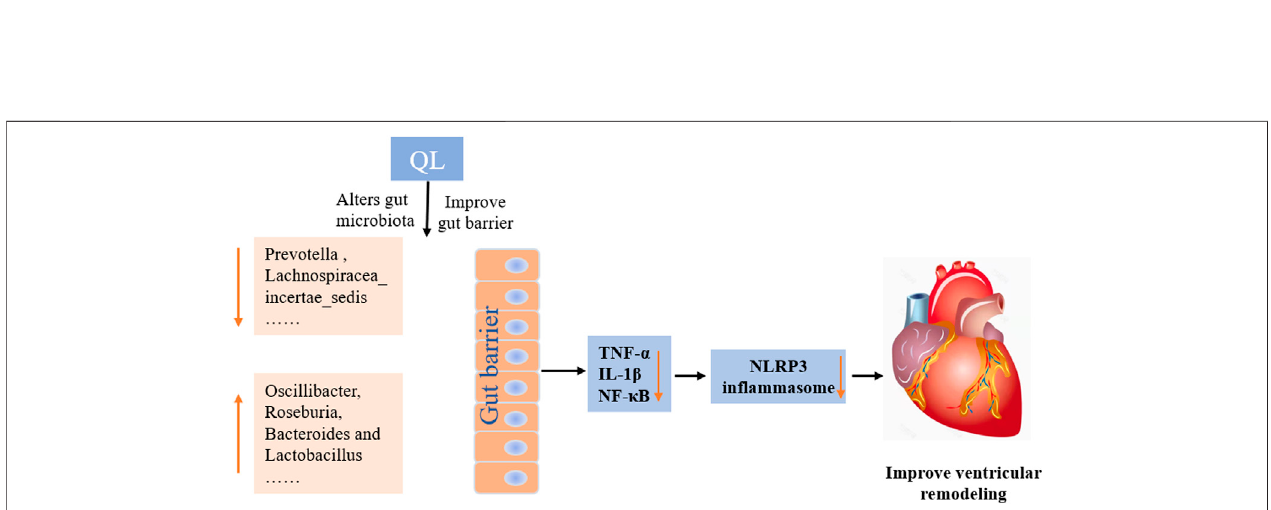
FIGURE7| MechanismsofQLinventricularremodelingofthetransverseaorticconstriction-inducedHFmodel.QLinterventioncouldamelioratethegutdysbiosis, improve the gut barrier, and inhibit gut-derived in fl ammatory cytokines entering the circulatory system. The heart-protective effect of QL might associate with the NF- κ B relative pathway inhibition and the NLRP3 in fl ammasome suppression in the cardiac tissue.